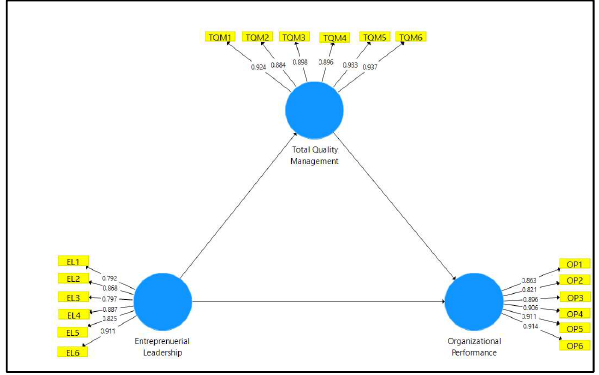
Fig. 2. Measurement Model (Factor Loadings)